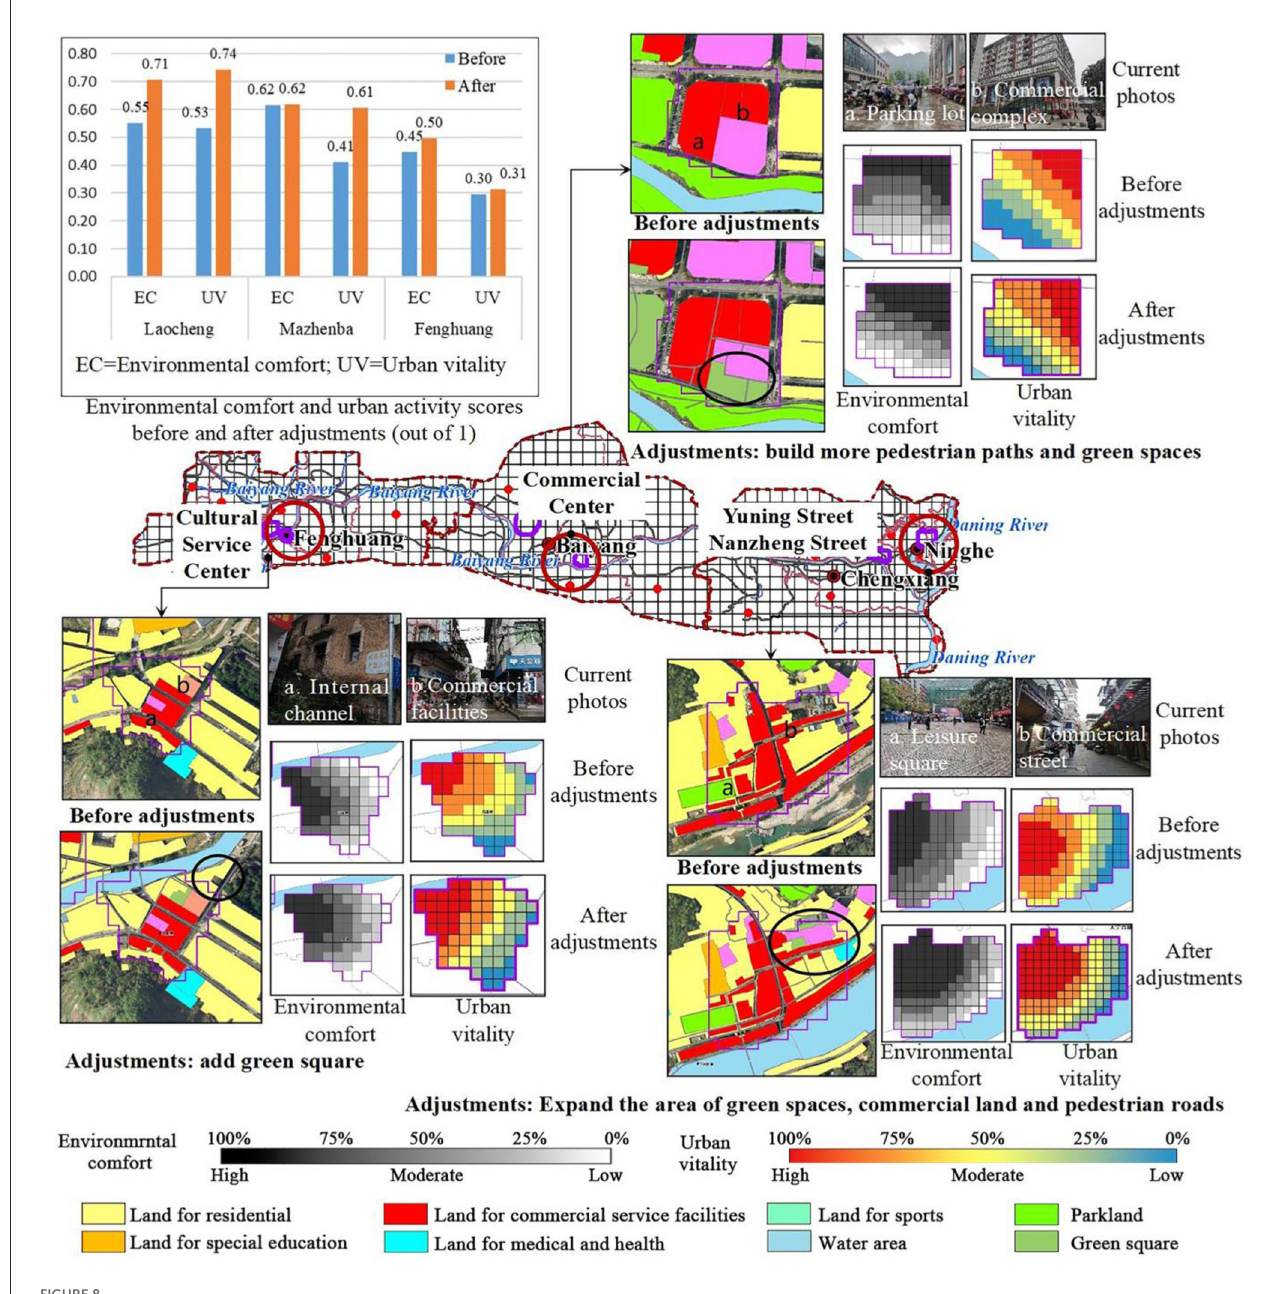
FIGURE8 Vitality before and after adjustments of environmental factors in commercial